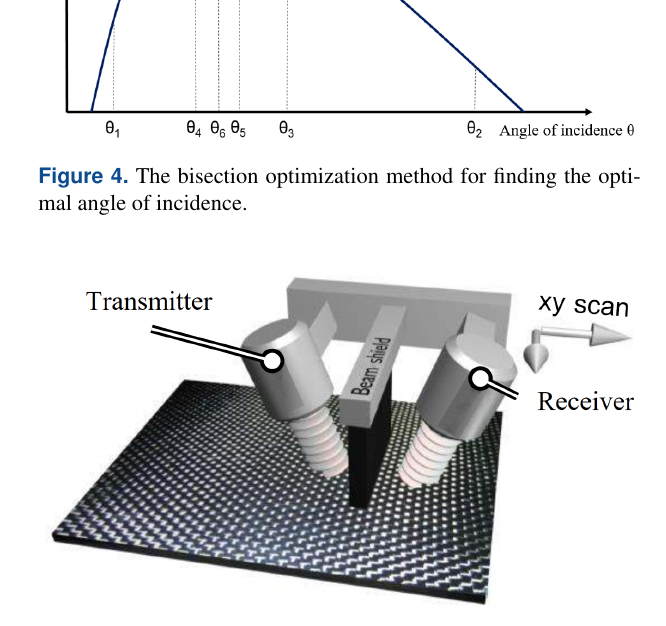
Figure 5. Setup for a C scan in re-emission, where the transmitter and receiver are placed on the same side of the specimen.